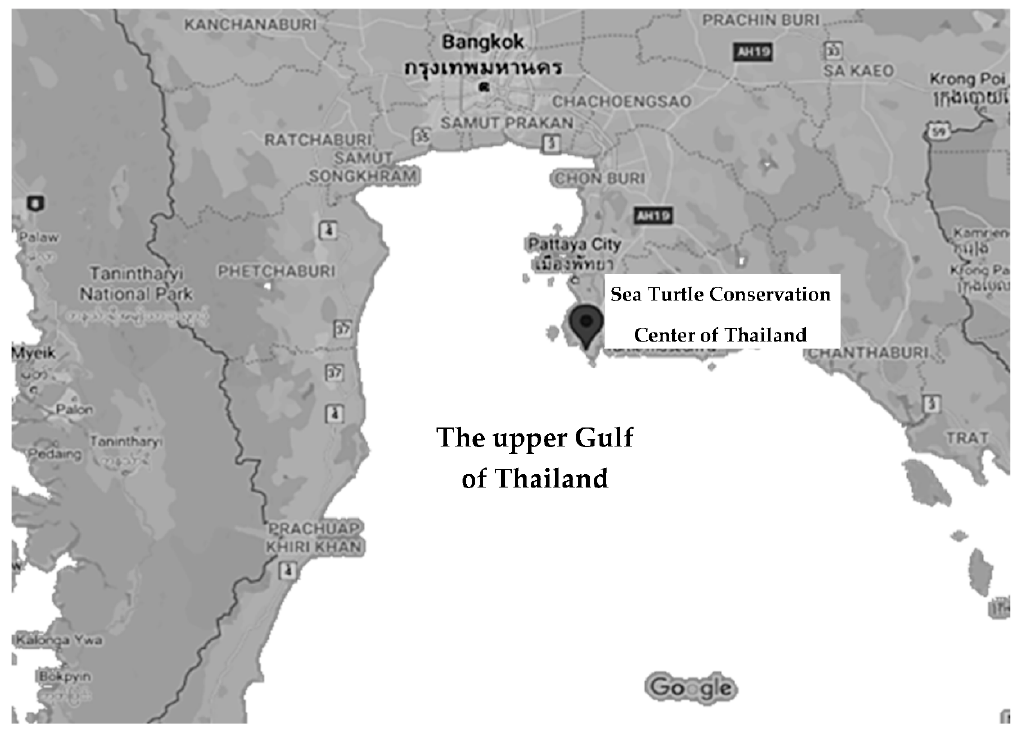
Figure 1. Location of the Sea Turtle Conservation Center of Thailand (STCCT). Source of map: Google Maps.